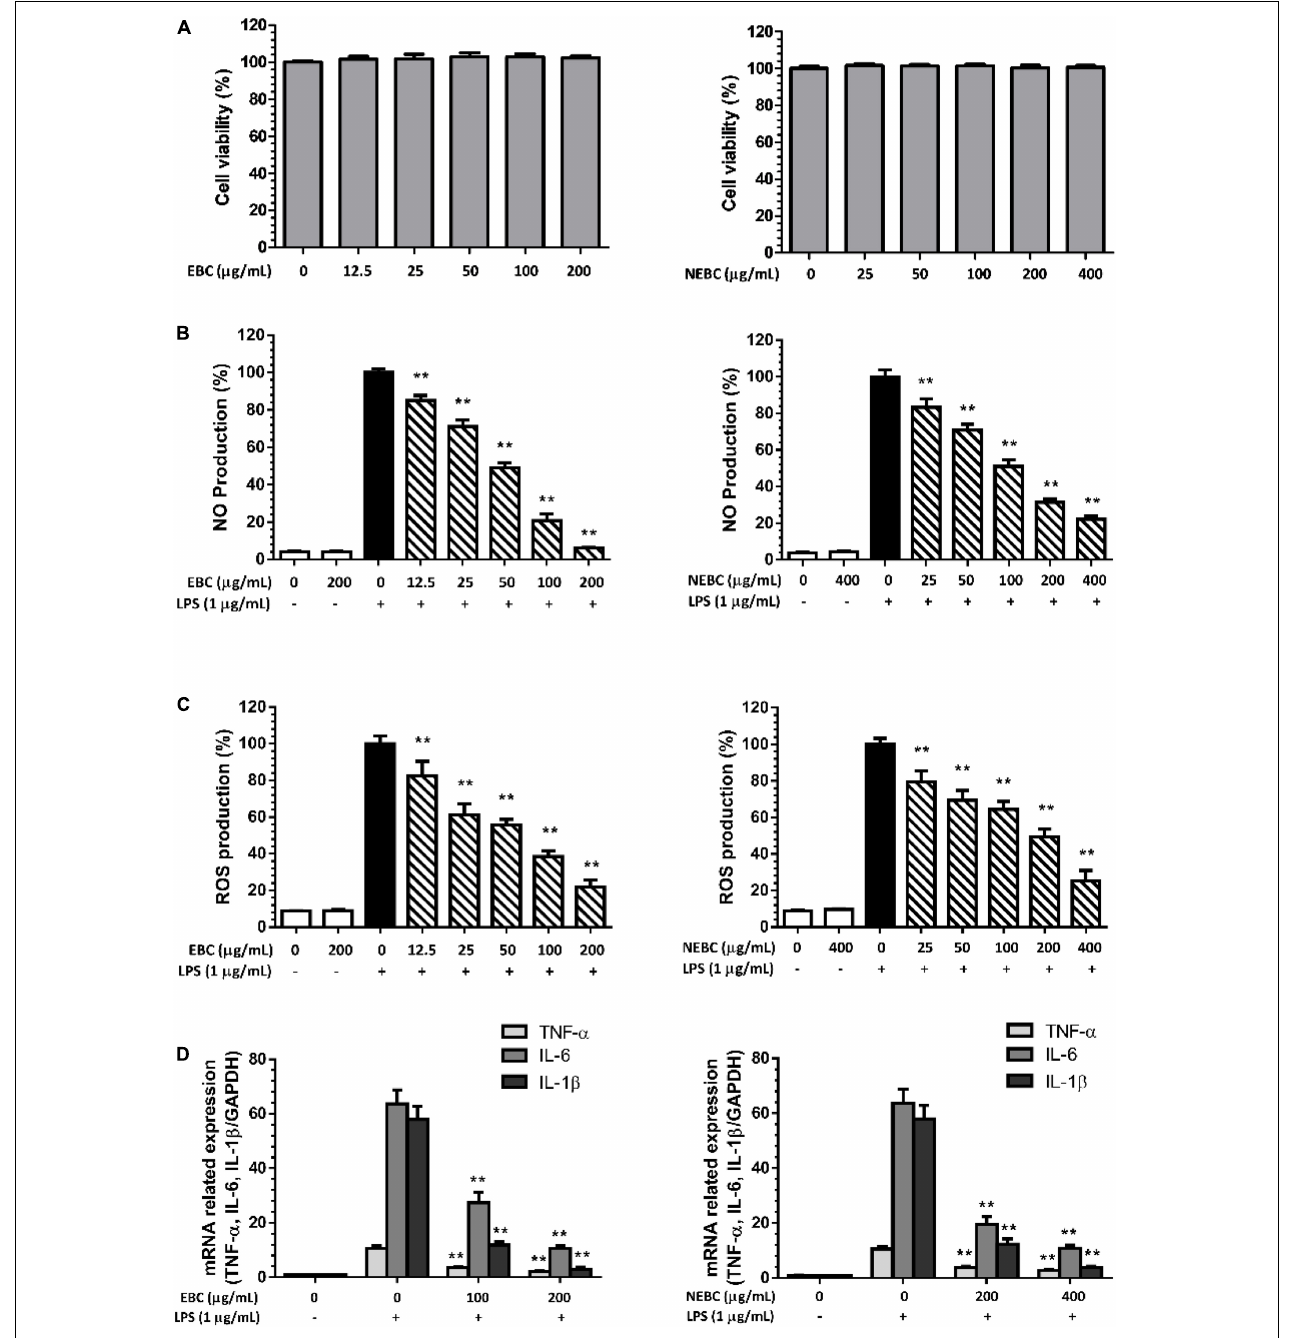
FIGURE 4 | Cytotoxicity of EBCs and NEBCs in macrophages (A) . Suppressive effects of EBCs and NEBCs on NO (B) and ROS (C) production in activated macrophages. Inhibitory effects of EBCs and NEBCs in messenger RNA (mRNA) expression level of tumor necrosis factor alpha (TNF- α ), Interleukin (IL)-6 and IL-1 β in activated macrophages (D) . ** indicates P < 0.01 in comparison with the LPS